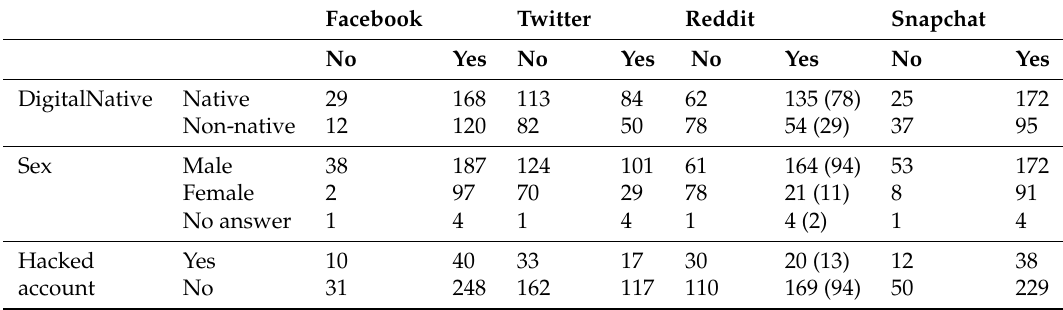
Table 14. Overview of categories distributed on the use of